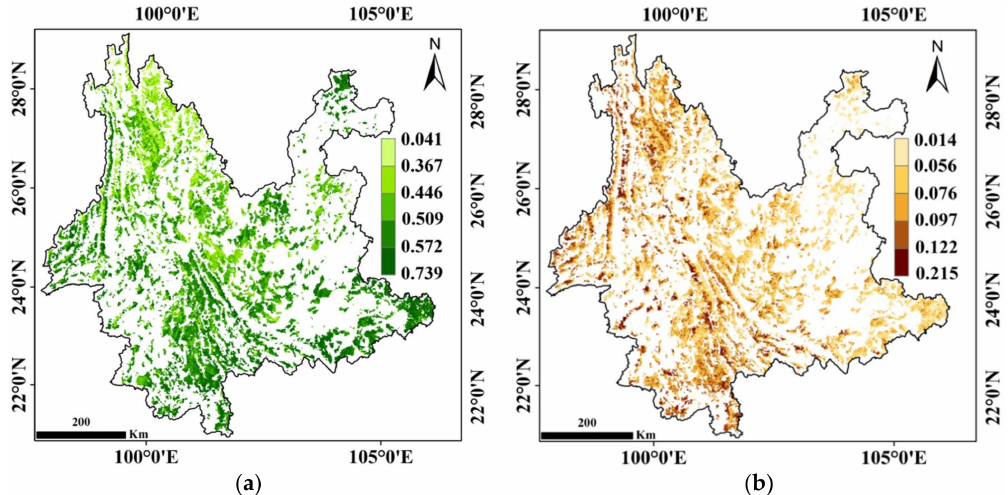
Figure 3. The spatial distribution of ( a ) the mean annual of EVI and ( b ) the annual standard deviation of EVI from 2001–2014. The EVI data were only for July in each